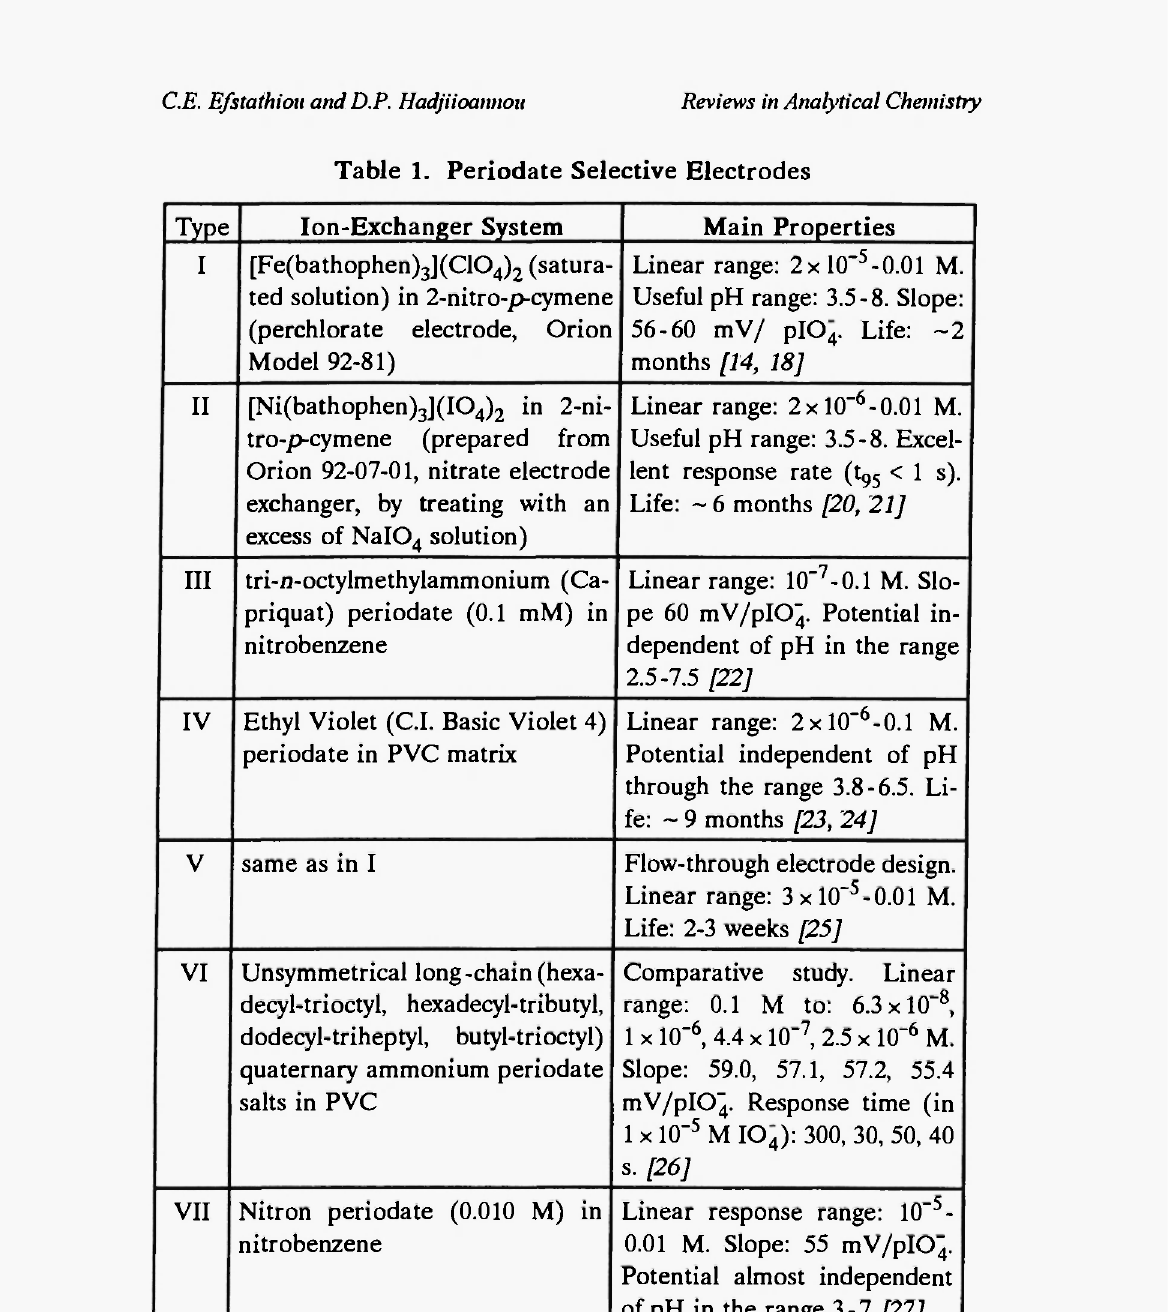
Table 1. Periodate Selective